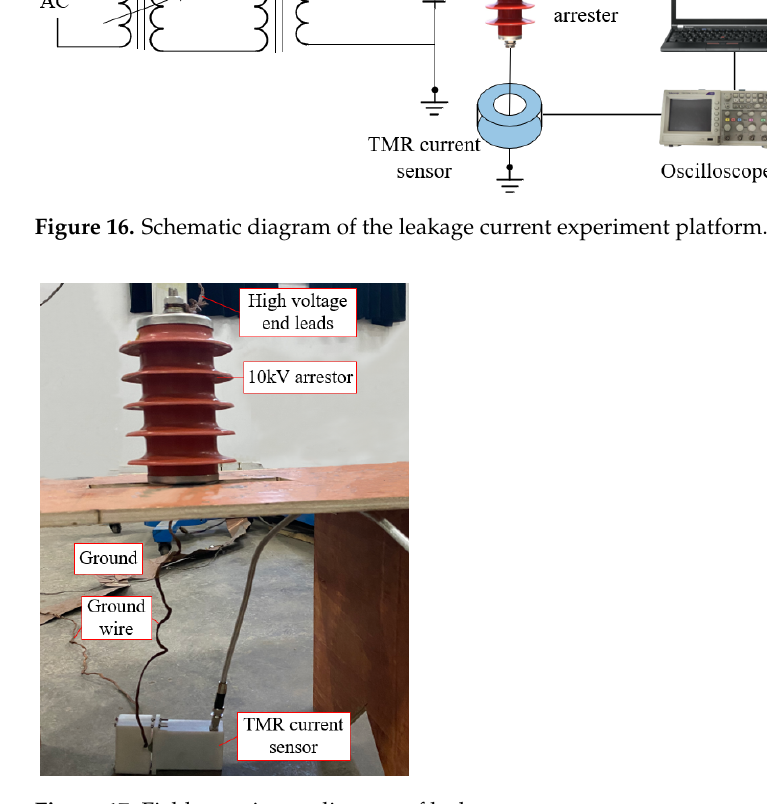
Figure 17. Field experiment diagram of leakage current.